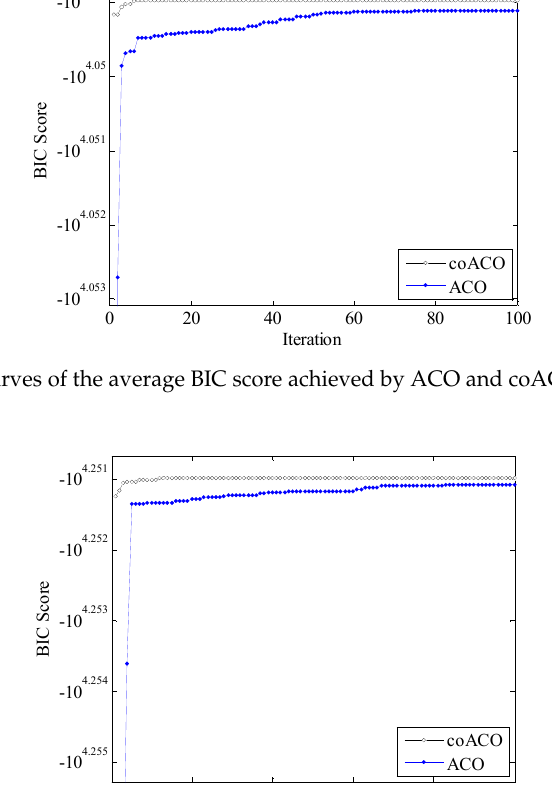
Figure 7. Evolution curves of the average BIC score achieved by ACO and coACO on the ASIA dataset with n = 8000. Algorithms 2018 , 11 , x FOR PEER REVIEW